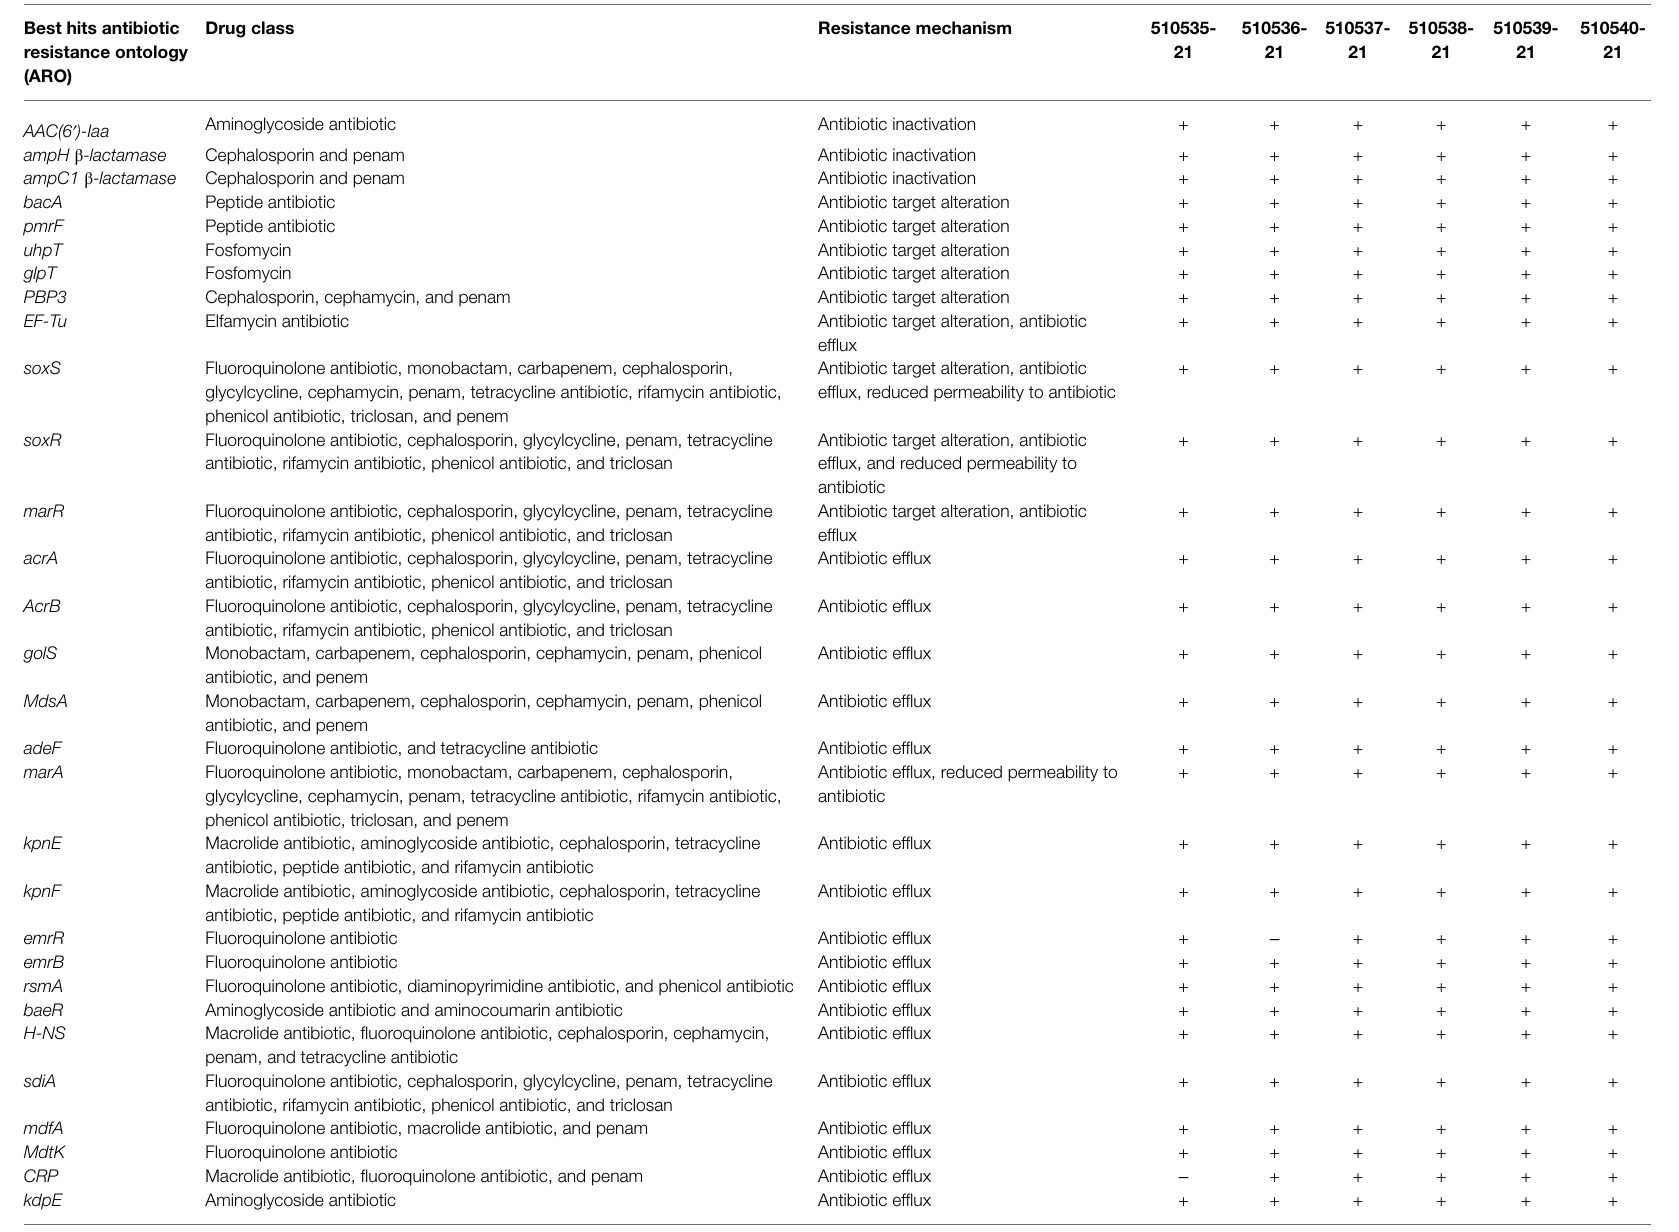
TABLE 4 | Antibiotic-resistant genes of S. Typhimurium strains identified by CARD. Best hits antibiotic resistance ontology (ARO)